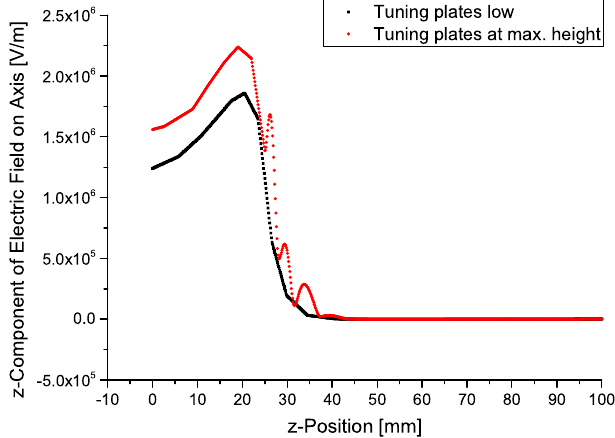
FIG. 19. z -component of electric field on axis at the entrance of the RFQ with variation of the tuning plate ’ s height. The gap field increases by a factor of 1.2 when the tuning plate in the first cell is raised from its minimum to its maximum